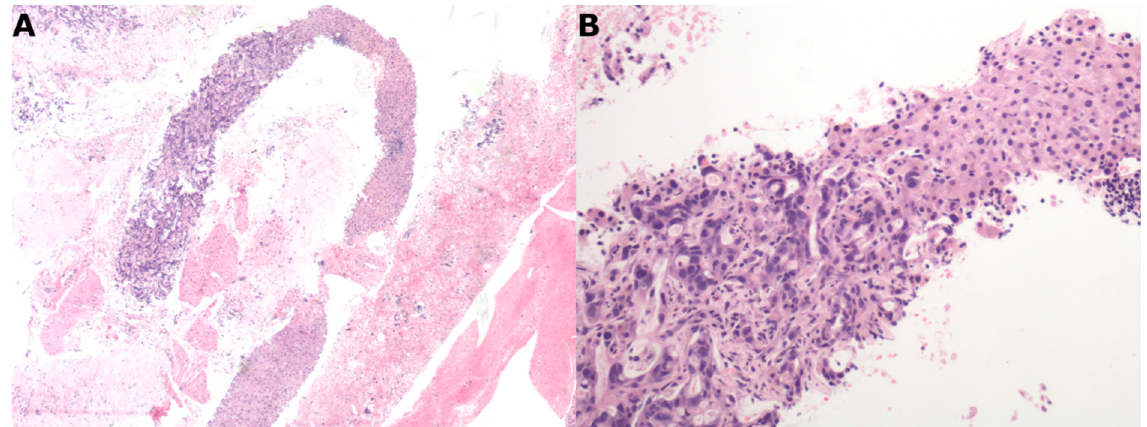
Figure 3. Liver metastasis from ductal adenocarcinoma of the pancreas. ( A ) 4 mm needle biopsy of a liver focal lesion with a representative area of adenocarcinoma occupying about 40% of the biopsy (upper left side) (4×, EE). ( B ) At higher magnification, adenocarcinoma cell aggregates (left side) replacing normal hepatocytes (right side) (20×, EE).